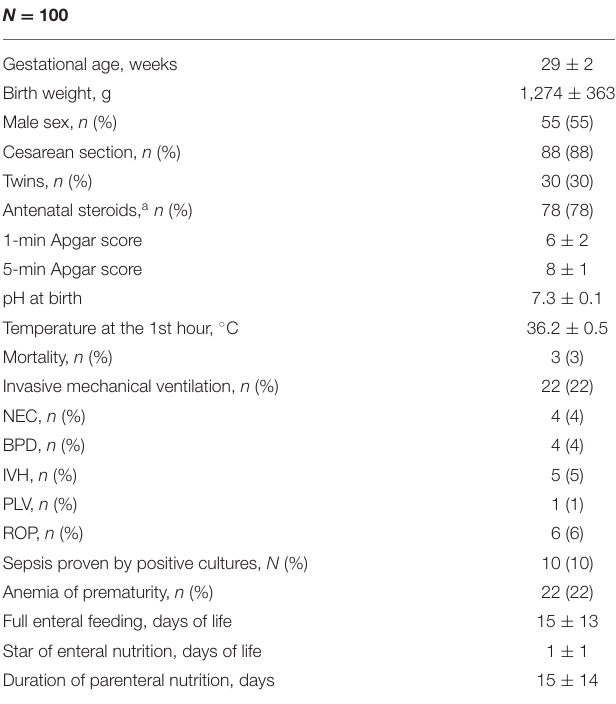
TABLE 1 | Clinical characteristics of study